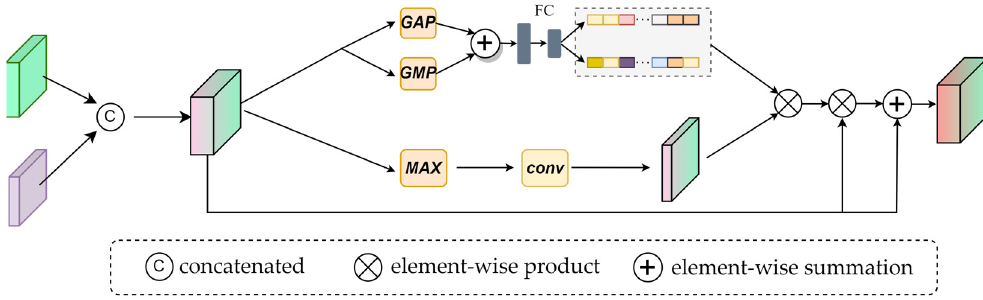
Figure 6. Speci fi c structure of the